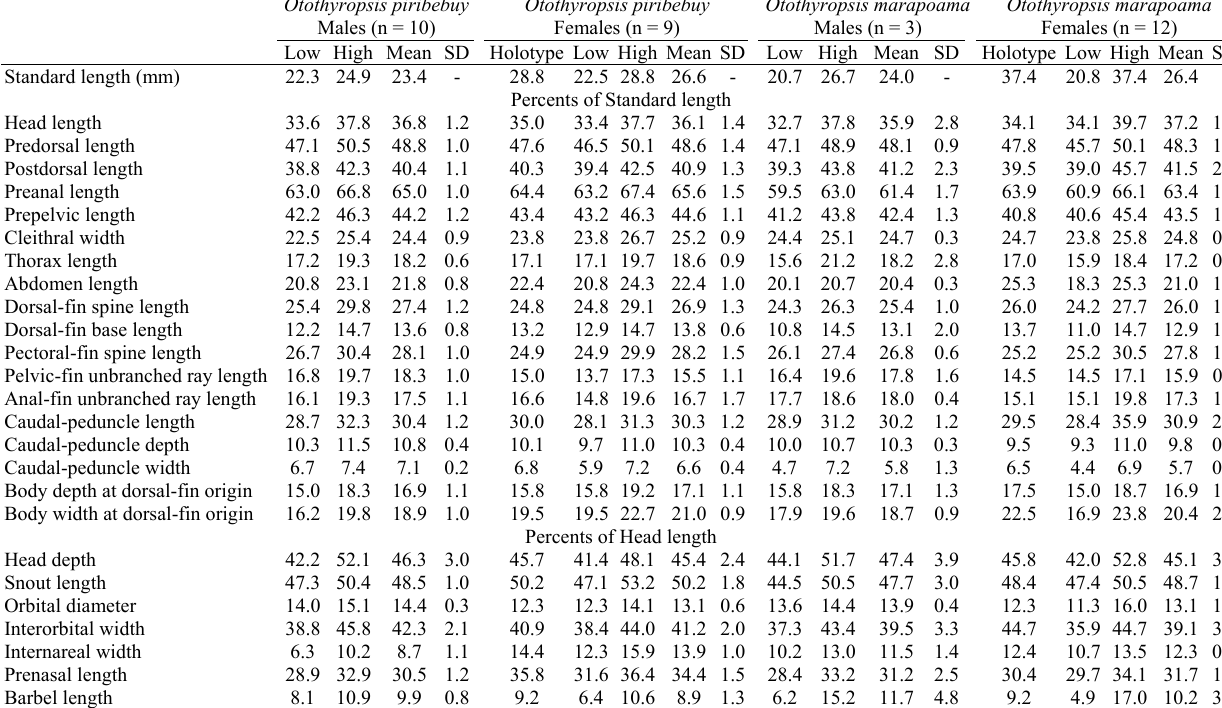
Table 2. Descriptive morphometrics of Otothyropsis species . Values are given for holotype and paratypes of O . piribebuy and O . marapoama . SD = Standard deviation. Otothyropsis piribebuy Otothyropsis piribebuy Otothyropsis marapoama Males (n = 10) Females (n = 9) Males (n = 3)